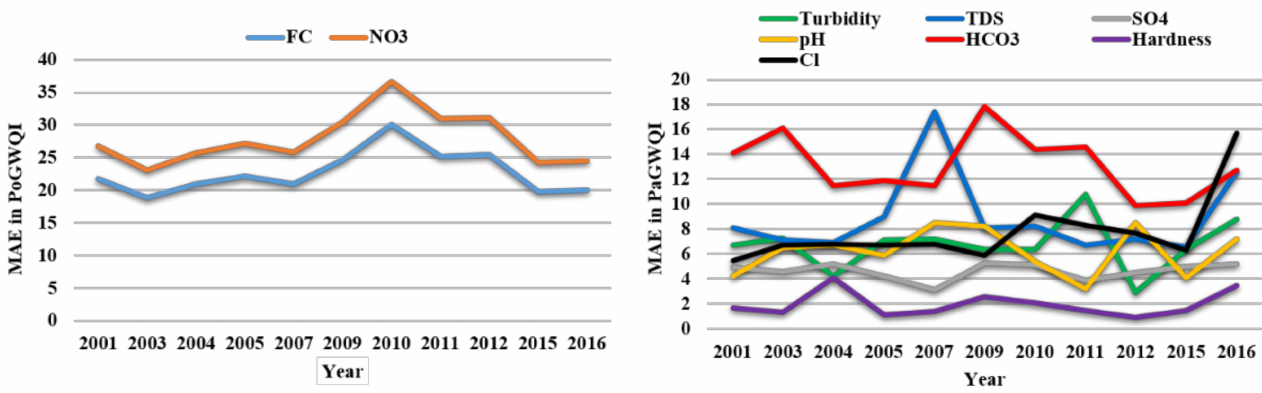
Figure 8. Sensitivity analysis of PoGWQI and